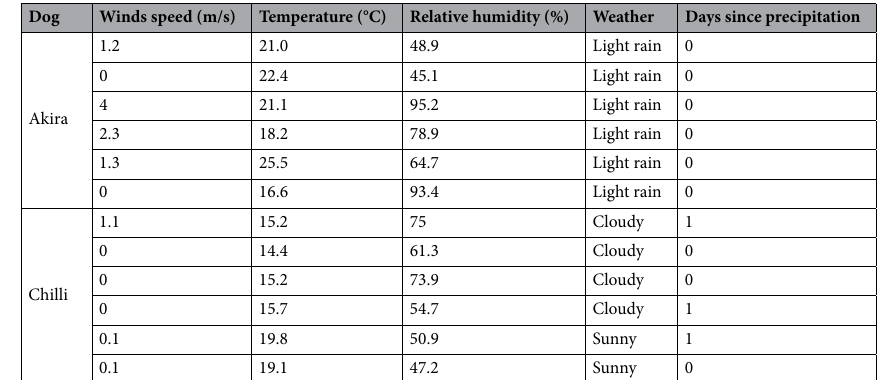
(Table 4). Temperature ranged from 14.4 to 25.5 °C with a mean temperature of 18.7 °C (± 3.4 SD) (Table 4). Relative humidity ranged from 45.1 to 95.2% with a mean percentage of 65.8% (± 17.5 SD) (Table 4). Data analysis. Of the four responses TP, FP, TN and FN, three parameters were calculated to evaluate the dogs detection performance in the final experiments 91 : correct responses among all responses, accuracy: (TP + TN) / (TP + TN + FP + FN), true positive responses among all target samples, sensitivity: TP / (TP + FN) and correct rejections of non-targets among all non-target samples: specificity: TN / (TN + FP). Accuracy express the percentage of correct responses (correctly identified targets and correctly rejected non-targets) among all possible responses (all scent samples in the experiment), while sensitivity express the percentage of correctly